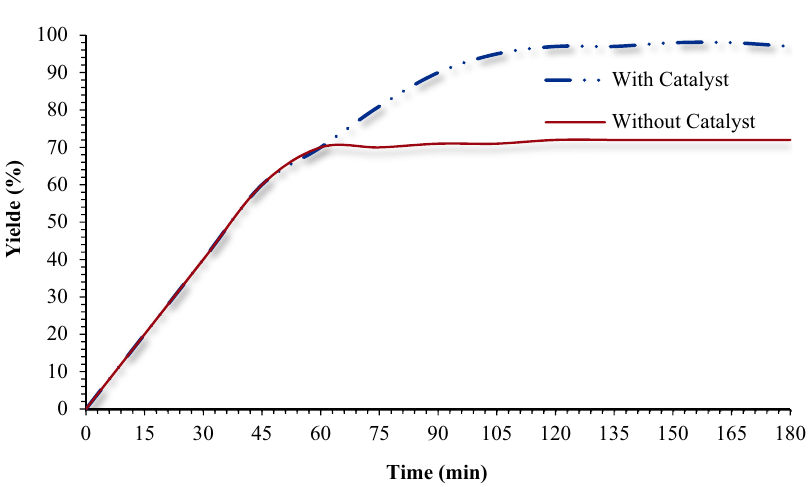
Figure 12. Hot leaching test for click reaction using Fe 3 O 4 @Pectin@(CH 2 ) 3 -Acetamide-Cu(II) under optimized